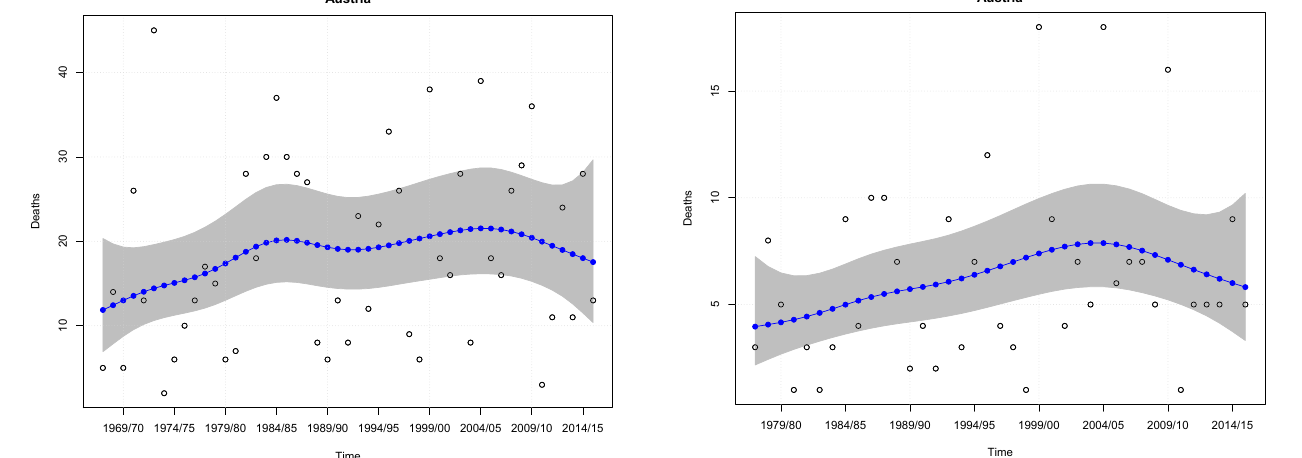
) annual total avalanche •